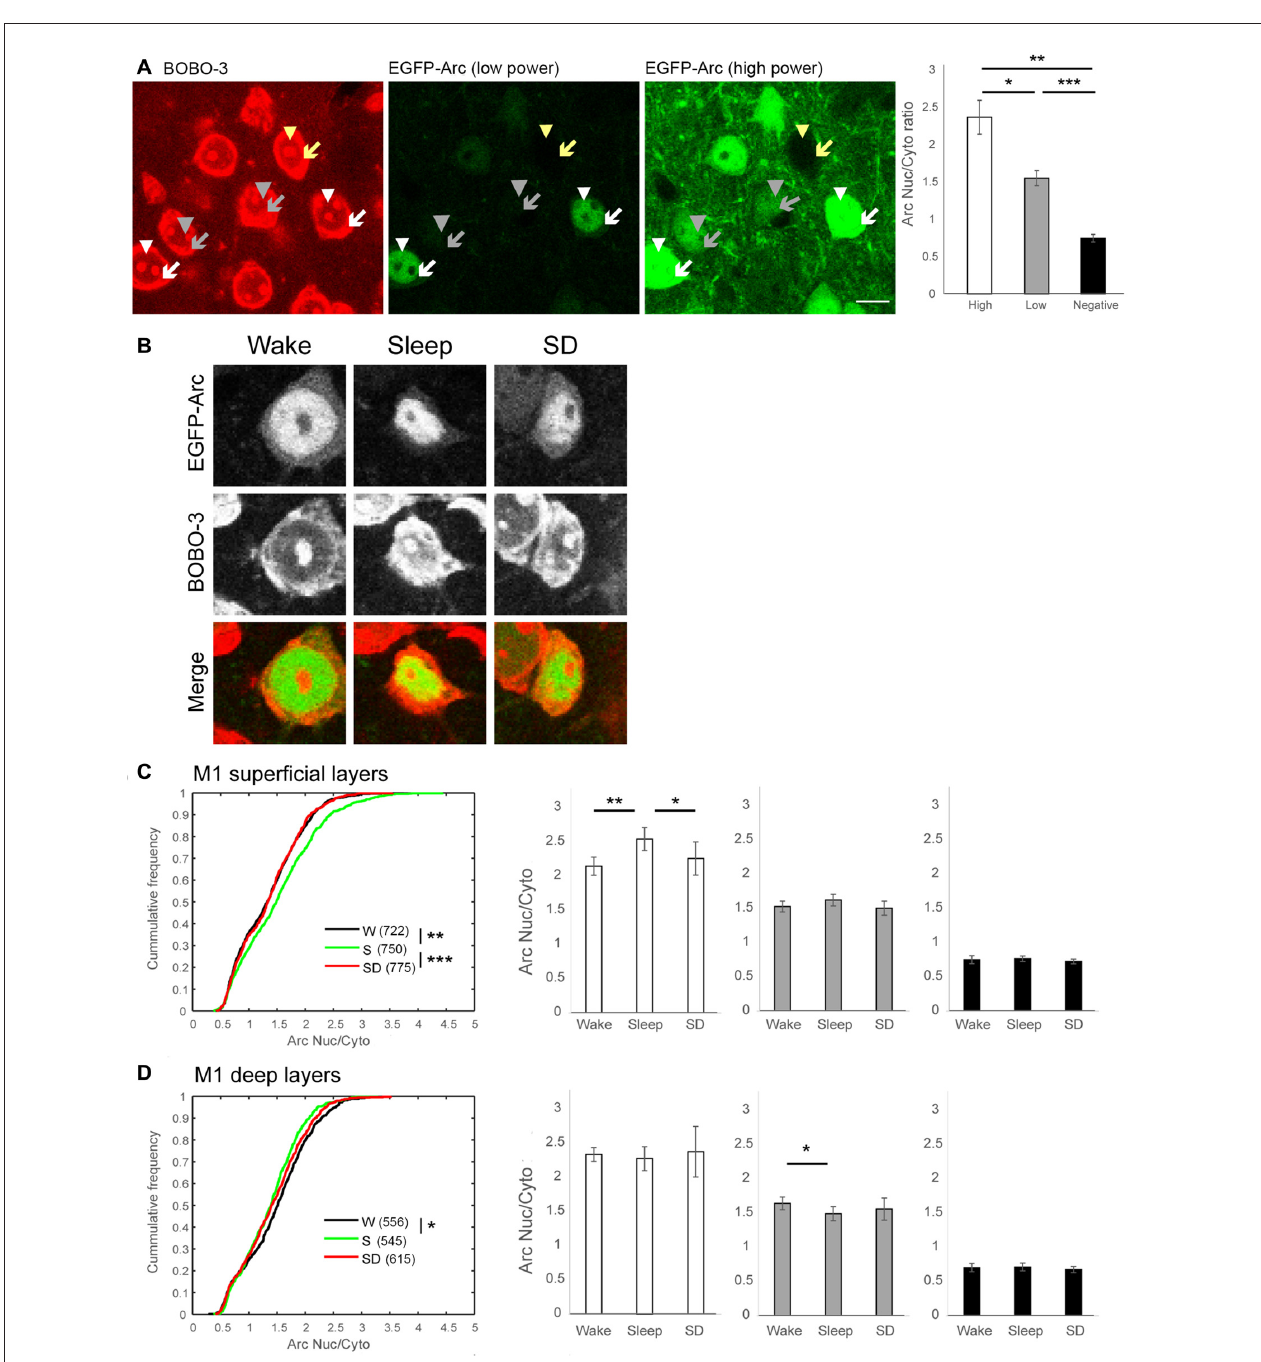
FIGURE 2 | Subcellular pattern of EGFP-Arc expression in M1. (A) Representative images of BOBO-3 staining (left panel) and EGFP-Arc signal at two different laser power levels (middle and right panel) from the same field (S mouse). Arrowheads and arrows indicate nucleus and cytoplasm of neurons with High Arc expression (white), with Low Arc expression (gray) and without Arc expression (yellow), respectively. Scale bar = 10 µ m. A positive correlation between Arc nucleus/cytoplasm (Nuc/Cyto) ratio and nuclear Arc signal was observed in all mice. Right, bars and error bars show mean and standard deviation of mean Arc Nuc/Cyto in High Arc, Low Arc and Arc negative neurons in each mouse. ∗ p = 4.86e-11, ∗∗ p = 2.23e-15, ∗∗∗ p = 3.20e-18, paired t -test using mean values for each mouse. (B) Representative images of subcellular localization of EGFP-Arc in each experimental group. EGFP-Arc images were acquired with the same parameters in all three conditions. (C,D) Summary of changes in Arc Nuc/Cyto in superficial and in deep layers. Left, cumulative frequency plots of Arc Nuc/Cyto ratio of all neurons analyzed from six mice per group (number of cells in parenthesis) ∗ p < 0.001, ∗∗ p < 0.0005, ∗∗∗ p < 0.000005, two-sample Kolmogorov-Smirnov test using Arc Nuc/Cyto ratio of all analyzed neurons. Right, higher Arc Nuc/Cyto after 2 h of sleep is observed in neurons with High Arc expression. Mean and standard deviation (6 mice/group). ∗ p < 0.05, ∗∗ p < 0.01, unpaired t -test using mean value of each mouse.